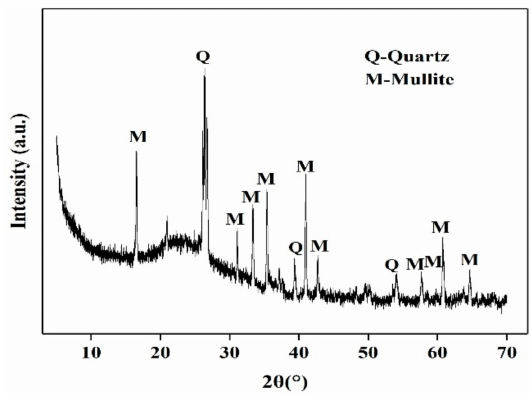
Figure 1. XRD spectrum for fly ash.